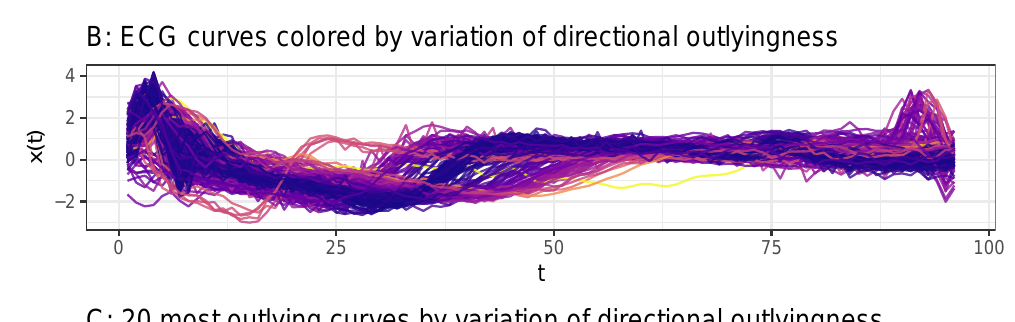
C: 20 most outlying curves by variation of directional outlyingness